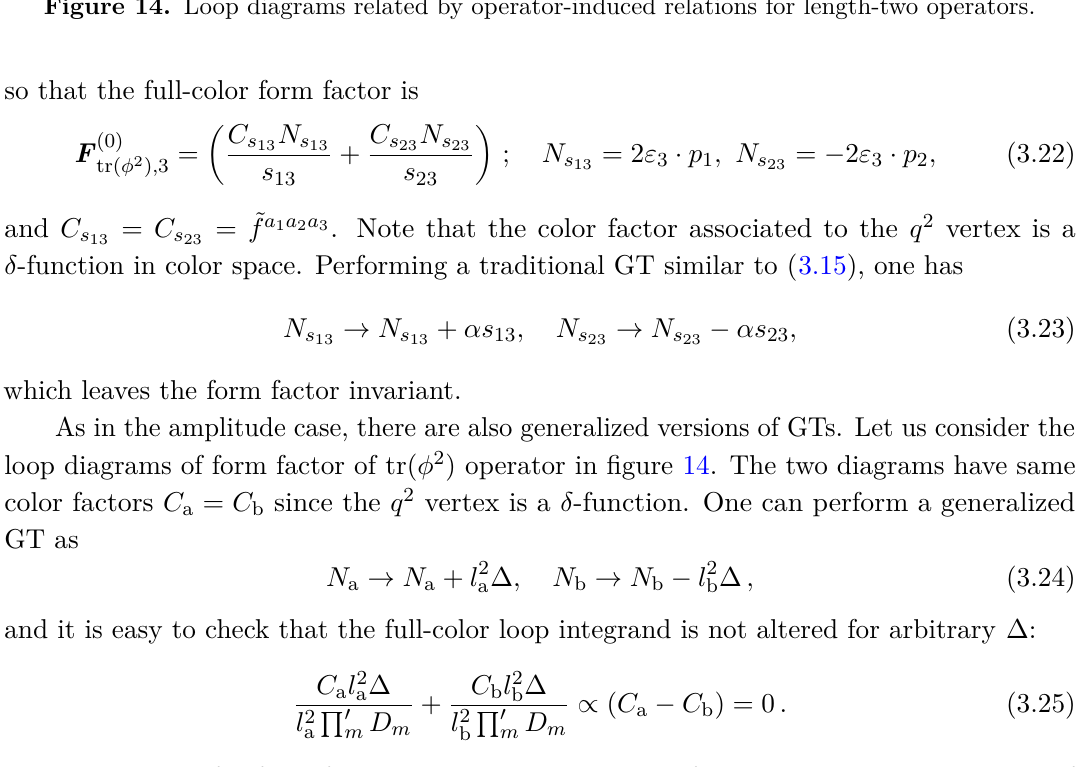
Figure 14. Loop diagrams related by operator-induced relations for length-two